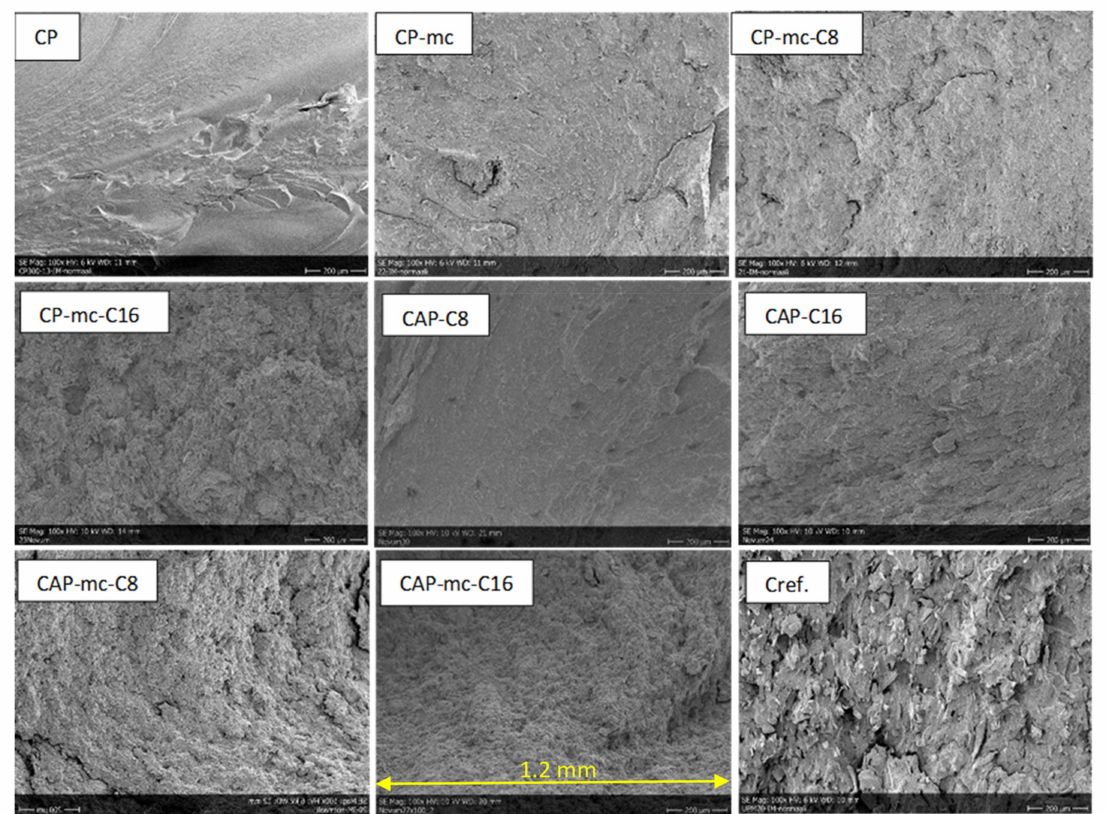
Figure 3. SEM-pictures with 100 × enlargement from cross-cut middle of the injection molded test bars. The width of each pictures is 1.2mm. CP is commercial cellulose acetate propionate with 13% commercial plasticizer; CP-mc is 20% microcellulose containing CP; CP-mc-C8 contains also 4% cellulose octanoate C8; CP-mc-C16 contains 4% of cellulose palmitate C16; CAP-C8 contains neat cellulose acetate propionate (CAP) with 17% C8; CAP-C16 contain 17% C16 in CAP; CAP-mc-C8 contains 20% mc and 17% C8 in CAP; CAP-mc-C16 contains 20% mc and 17% C16 in CAP and Cref is PLA-based material with 20% cellulose